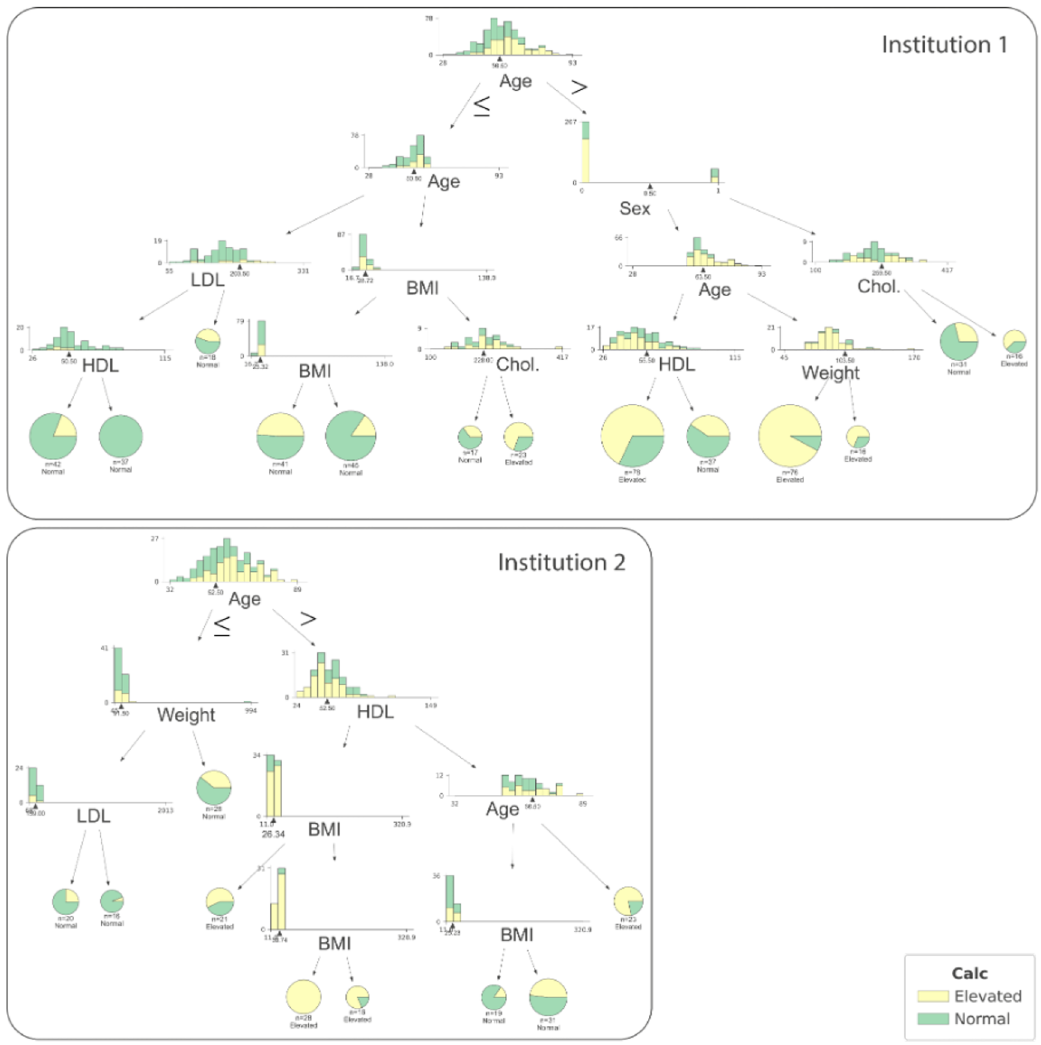
Figure 2: Decision trees trained with the data from institution 1 and 2; both trees are first split by age, but already diverge at the next level